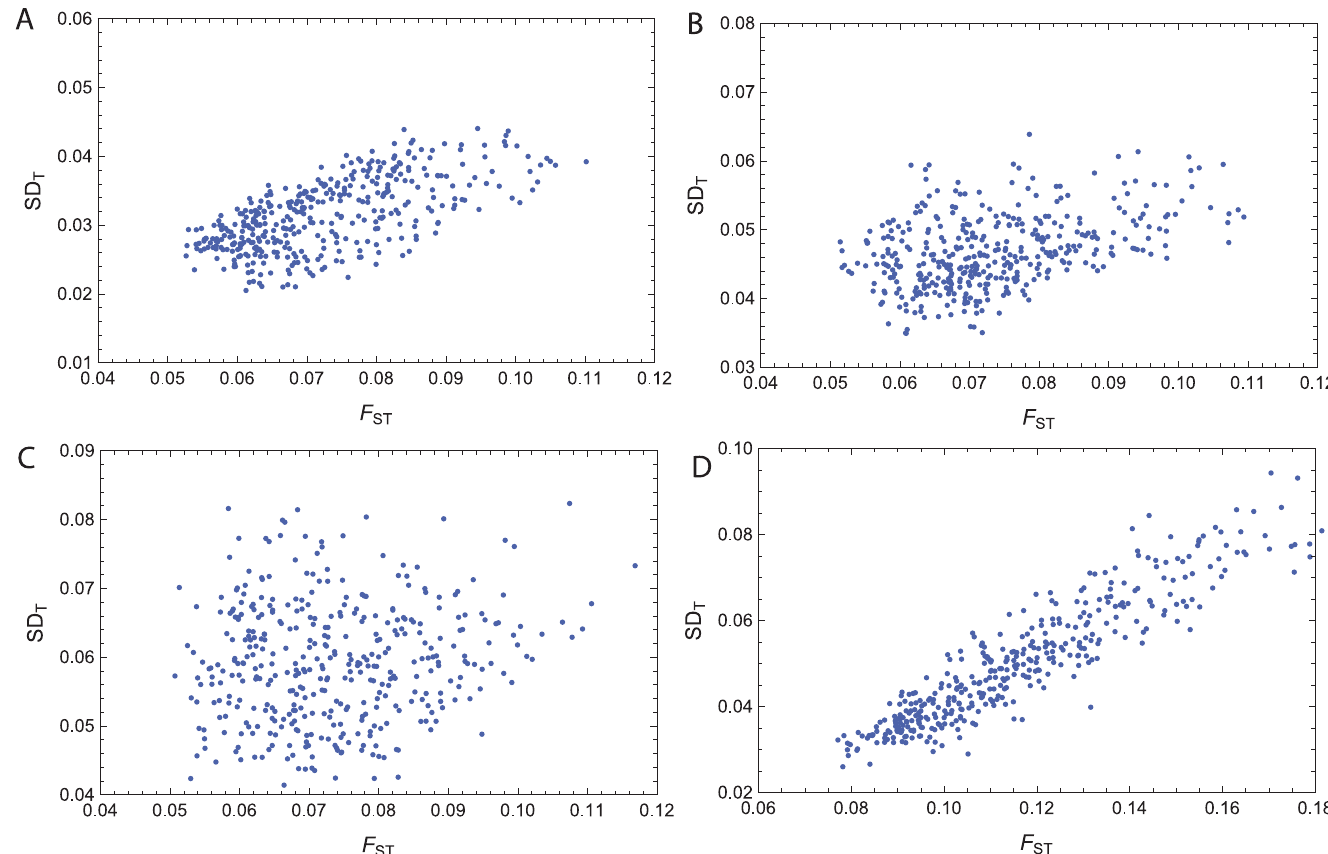
Fig 9. Scatter plots indicating a positive correlation for SD T and F ST . Each dot represents the two statistics computed for data sampled from our population model with 1000 SNPs and allele frequencies from Beta distributions. The Pearson product-moment correlation coefficient of F ST and SD T is 0.67 for plot (A) with panmictic populations, 0.38 for plot (B) with slightly varying structure in subpopulations, 0.14 for plot (C) with highly varying structure in subpopulations, and for 0.94 for plot (D) with three panmictic populations.